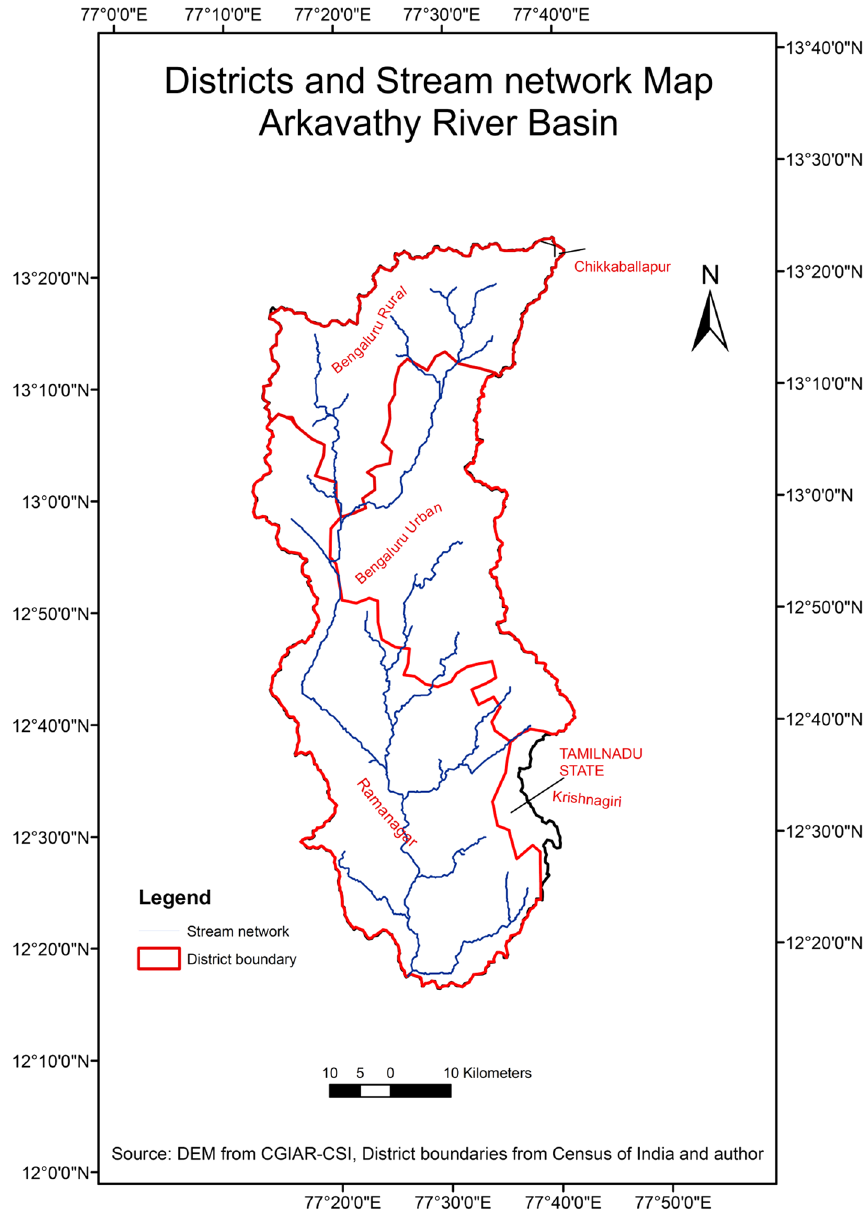
Fig. 3 Stream network